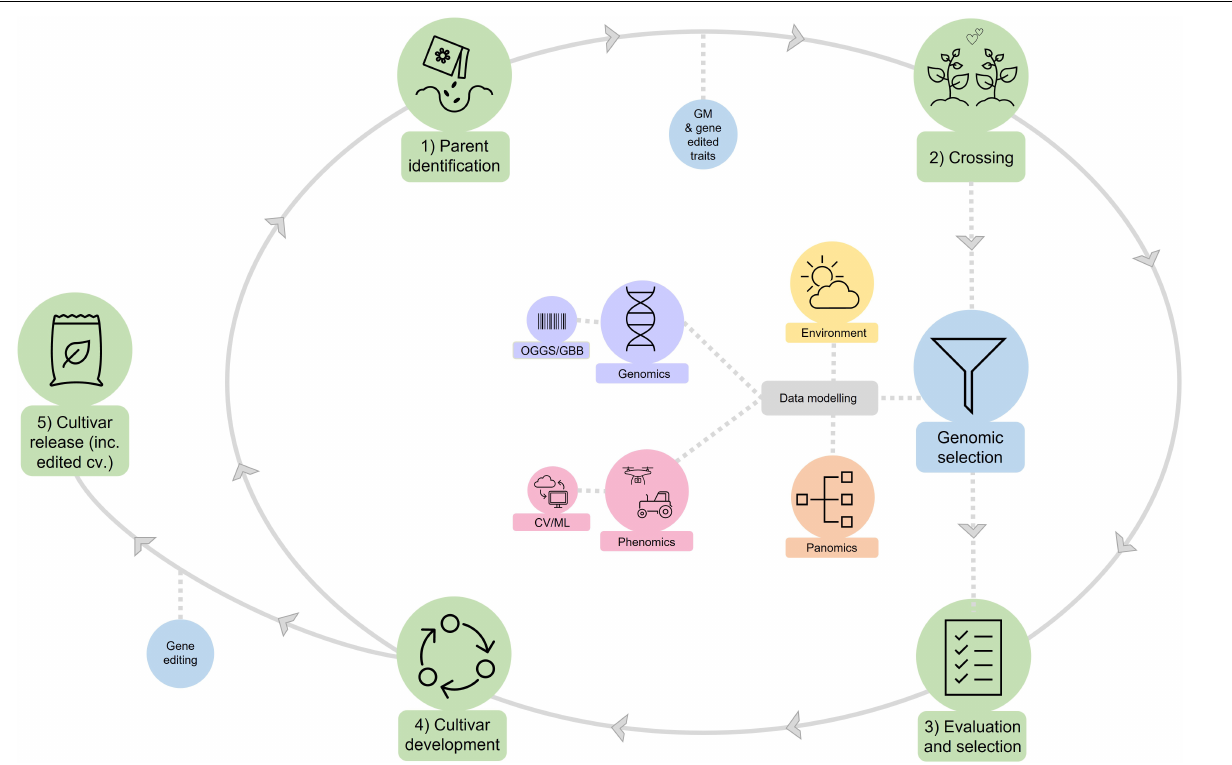
FIGURE 8 | Pathfinder: A conceptual framework for how the CSIRO cotton breeding program aims to meet the challenges of the 21st Century. The traditional breeding operations of (1) Parent selection; (2) Crossing; (3) Evaluation and selection; (4) Cultivar release (all highlighted in green) form the foundation of the program. The CSIRO cotton breeding program will augment this traditional breeding process through the deployment of the new breeding technologies of genomic selection, genetically modified traits, and gene editing (highlighted in blue). Complex datasets encompassing genomics (including omics-guided genomic selection, OGGS, and gene-based breeding, GBB), season-long quantification of the plant (i.e., phenomics, including computer vision and machine learning, CV/ML, based phenomics, and panomics) and its environment will be integrated into genomic selection using algorithmic